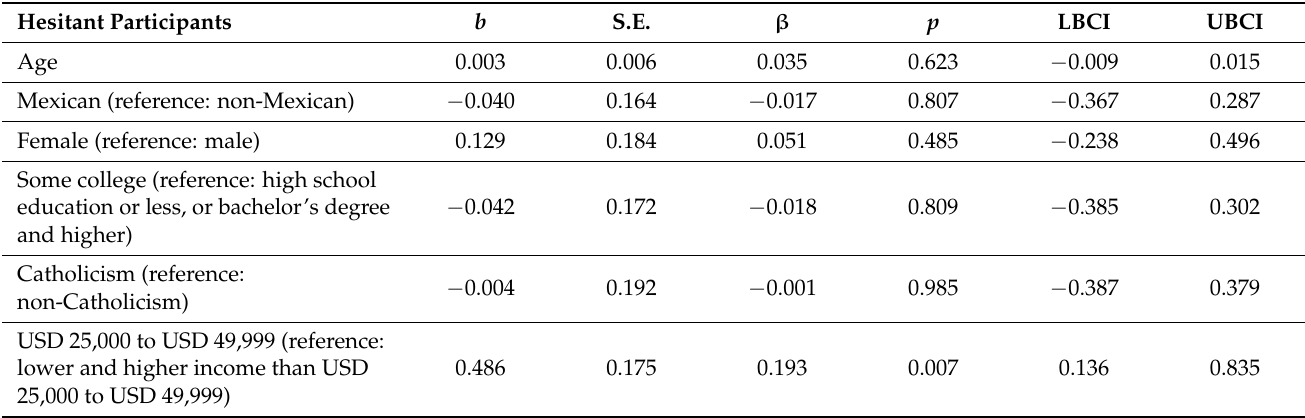
Table 5. Multiple regression models for initiation of COVID-19 vaccination among hesitant and non-hesitant